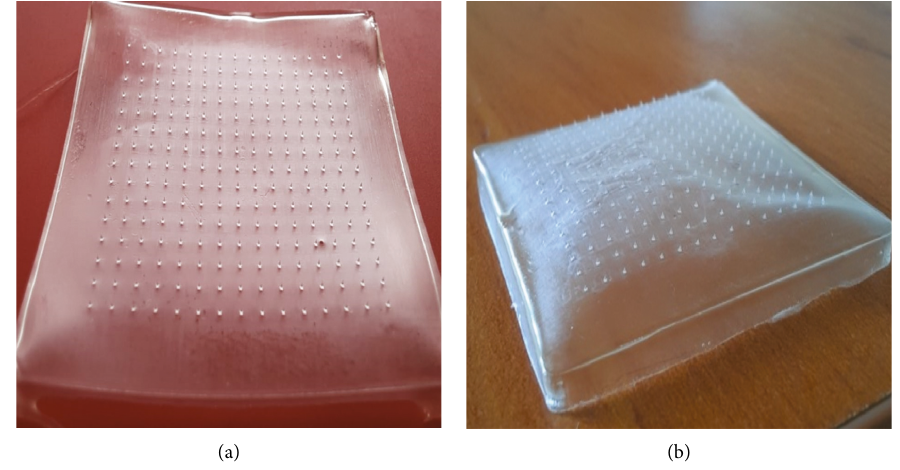
Figure 5: (a) Blank patch and (b) Bacopa monnieri- SLNs loaded